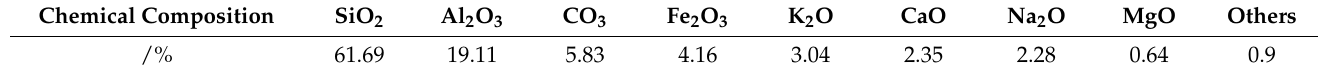
Table 1. Chemical composition of raw coal gangue (mass fraction).